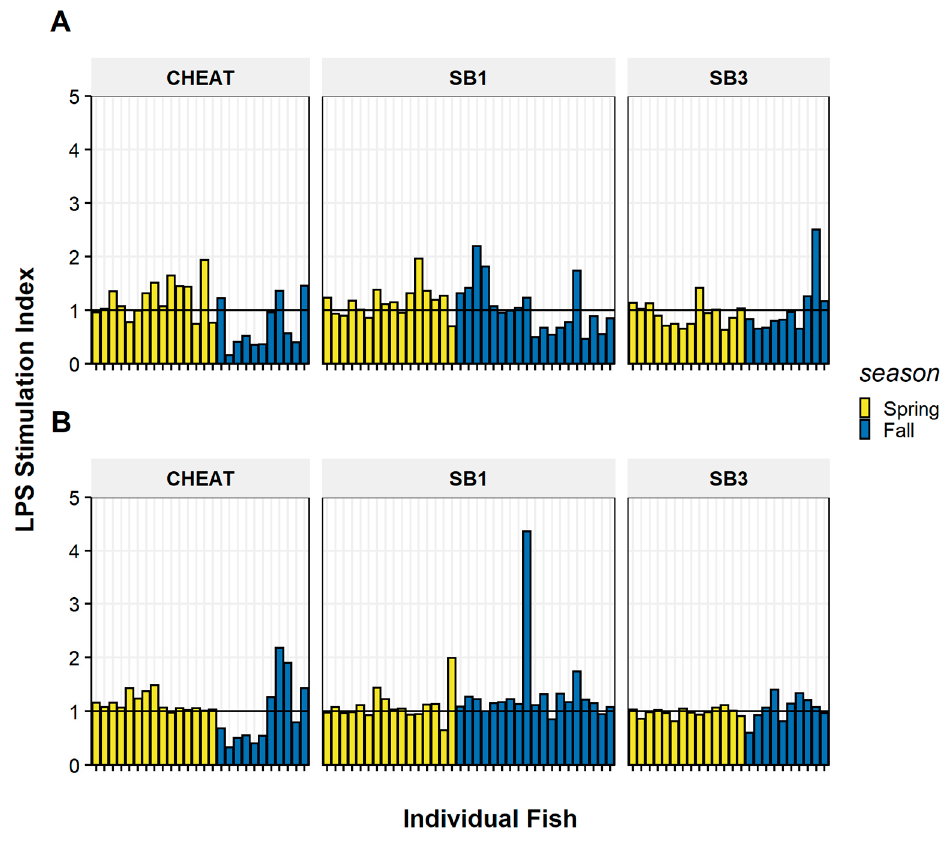
Figure 5. Stimulation indices for IgM+ ( A ) and IgM − ( B ) lymphocytes after exposure to LPS for in- dividual fish during spring (yellow) and fall (blue) for all sampling sites. The horizontal line at 1 indicates the stimulation index threshold.